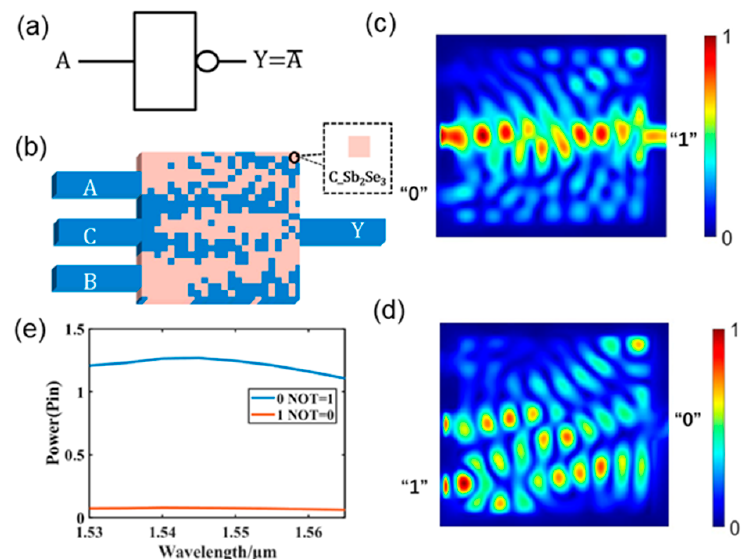
Figure 4. Photonic NOT logic gate. ( a ) Graphical symbols of the NOT logic gate; ( b ) the designed NOT logic gate; ( c , d ) light field intensity distributions in all operations of the NOT logic gate; ( e ) output optical power diagram of the NOT logic gate in the C-band.